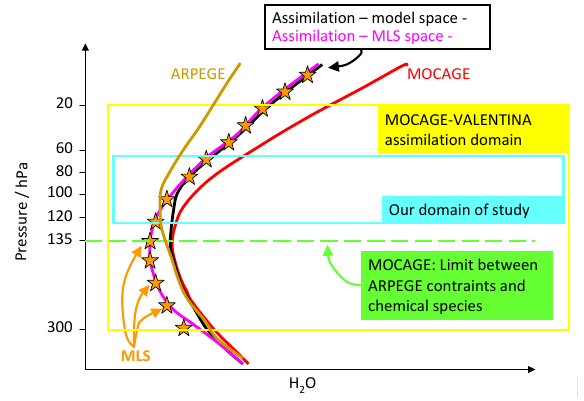
Figure 3. Schematic representation of the H 2 O vertical profiles used in the present analysis: MLS (orange stars), MOCAGE (red line), ARPEGE (brown line), assimilation in the MLS space (in time and space coincidence with MLS observations, pink line) and assimilation in the model space (in time and space coincidence with the model outputs, black line). In MOCAGE, H 2 O is constrained to ARPEGE meteorological analyses below 135hPa (horizontal dashed green line), and is considered as a chemical species above 135hPa. MLS observations are assimilated from 300 to 20hPa. Our domain of study lies from 121 to 68hPa in the